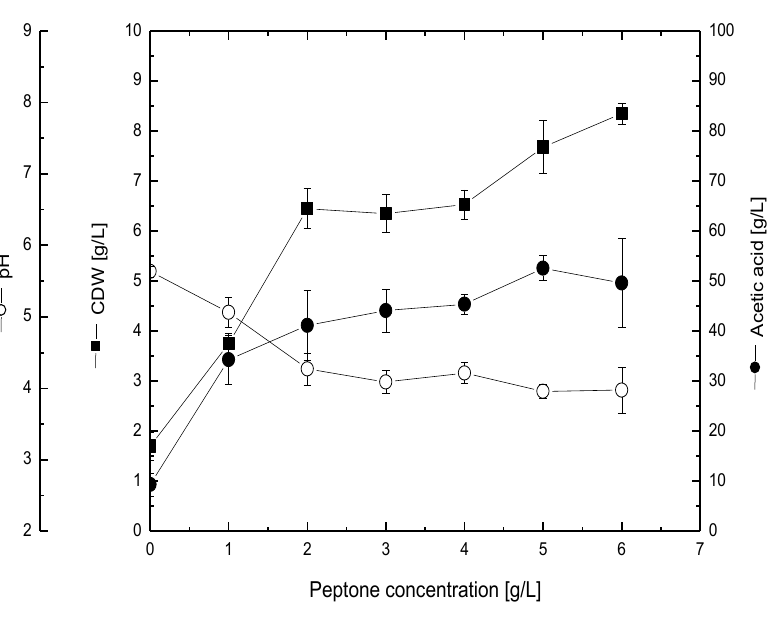
Figure 4. Effect of different peptone concentrations on cell growth, acetic acid production and pH during cultivation in shake flask